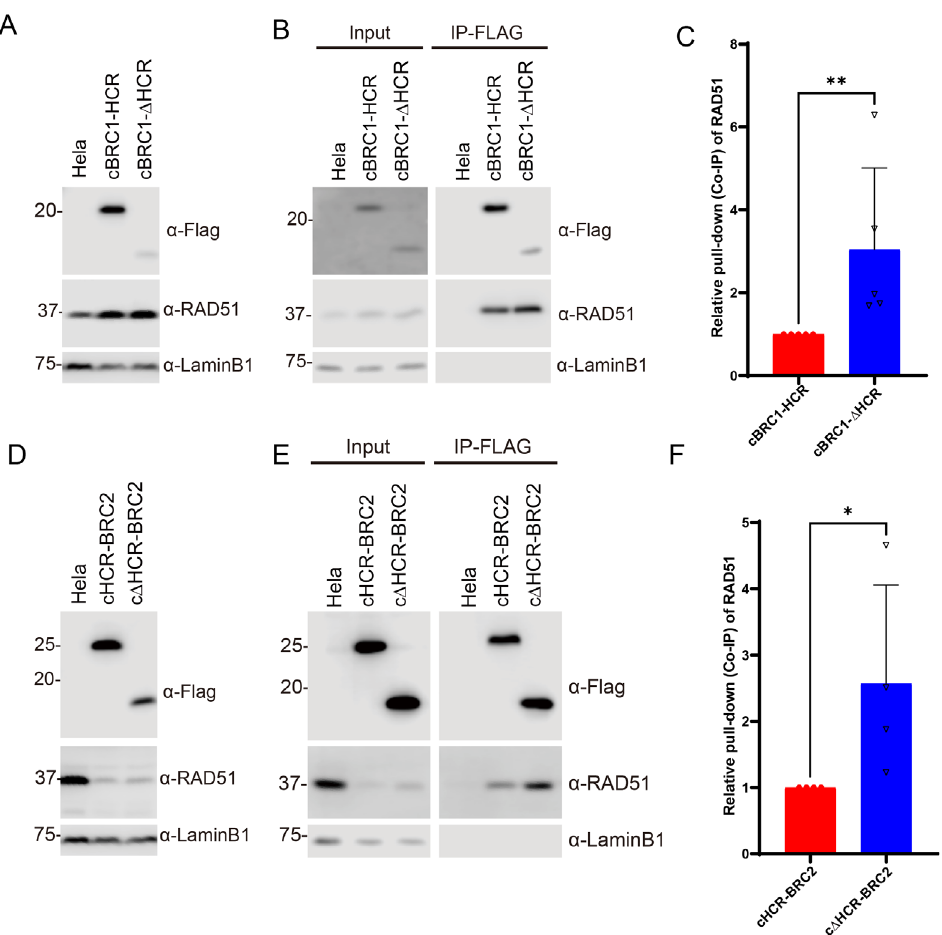
Figure 2. The highly conserved region (HCR) reduced the interactions between BRC repeat 1 (BRC1) or 2 (BRC2) and RAD51. ( A ) Expression of exogenous canine BRC1 peptide and endogenous RAD51. HeLa cells stably expressing FLAG-HA-tag and nuclear localization signal (NLS)-fused cBRC1-HCR (993–1139 aa) or cBRC1- Δ HCR (993–1100 aa) were determined via Western blotting using anti- FLAG and anti-RAD51 antibody, and anti-Lamin B1 antibodies (as loading control) ( B ) Co-